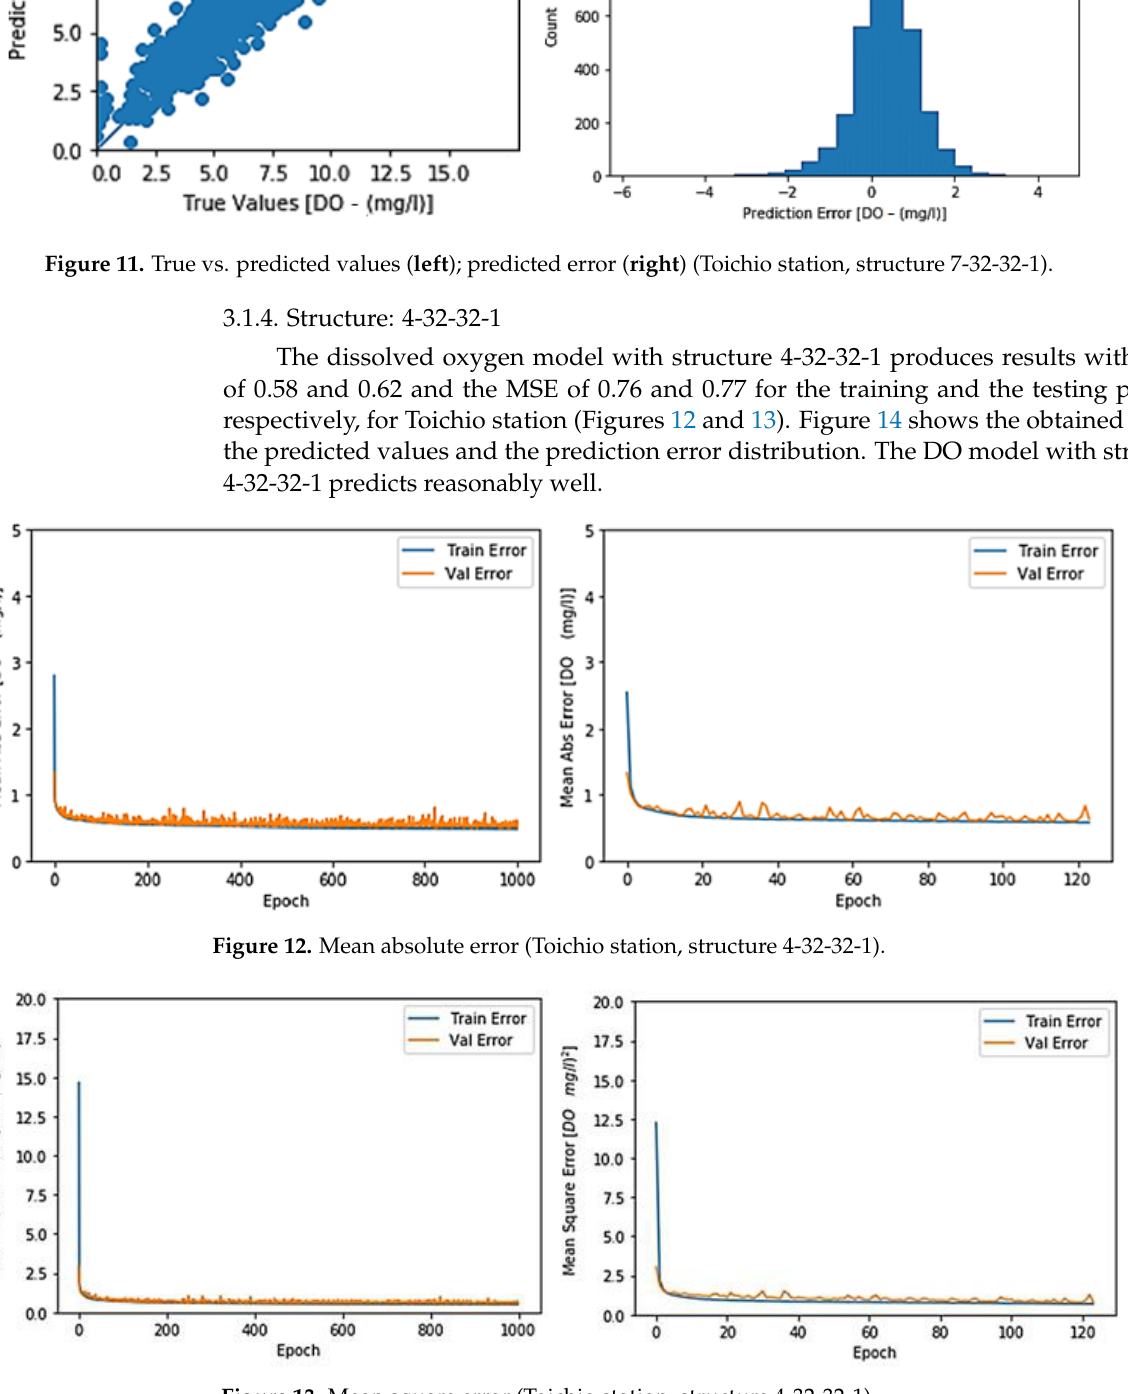
Figure 13. Mean square error (Toichio station, structure 4-32-32-1).